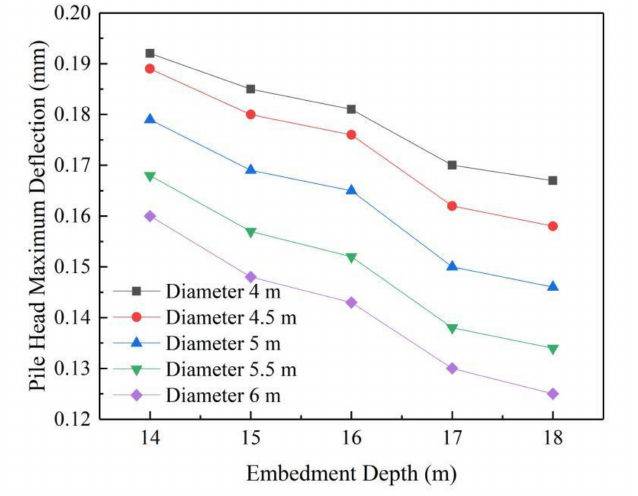
Figure 10. Influence of embedment depth and wall thickness on maximum deflection of pile